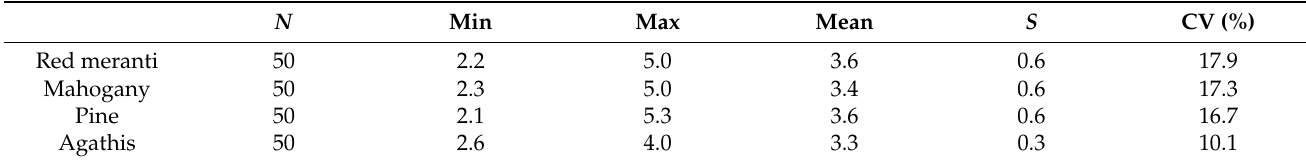
Table 5. The small timber beams’ ductility ratio ( µ ).